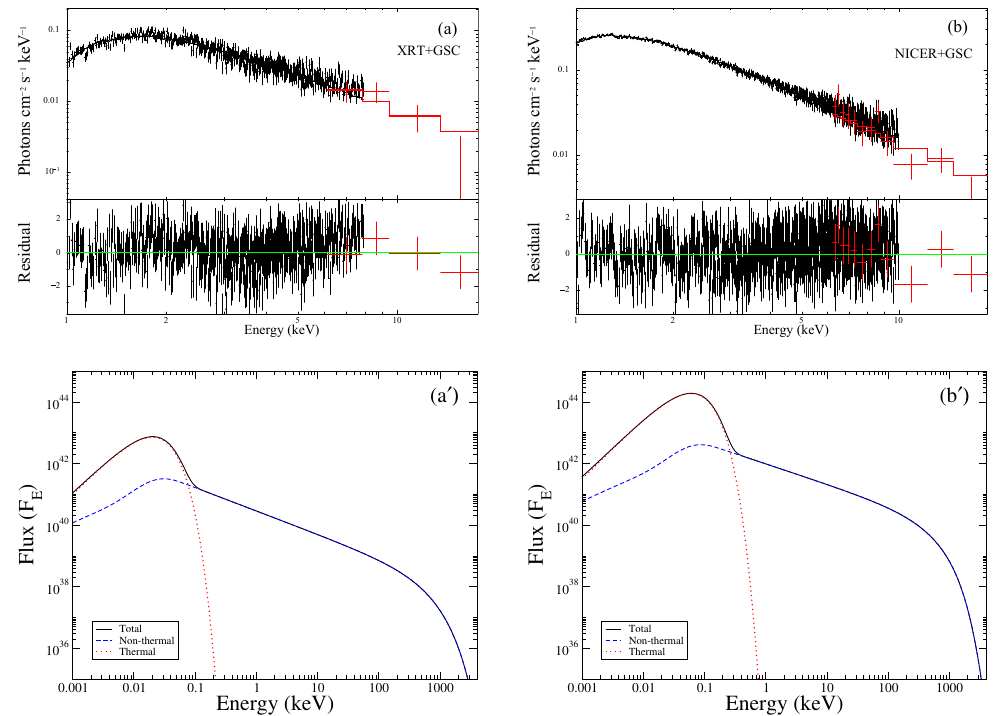
Figure 4. TCAF model-fitted combined spectra of ( a ) Swift/XRT (OBSID 00011107047) with MAXI/GSC (MJD = 58,690.23) in 1–20 keV in the top left panel, and ( b ) NICER (OBSID 2200530170) with MAXI/GSC (MJD = 58,675.9) in 1–20 keV in the top right panel. Bottom panels ( a (cid:48) , b (cid:48) ) shows the unabsorbed TCAF model-generated spectra, which were used to fit the top panel spectra. Here, model flux ( F E ) is plotted in units of photons cm − 2 s − 1 keV − 1 . Total flux is plotted with the solid curve. The dotted red curve marks the thermal component through bremsstrahlung and Comptoniza- tion processes from the Keplerian disk of the pre-shock flow, and the dashed blue curve marks the non-thermal component through inverse Comptonization from the hot Compton cloud or